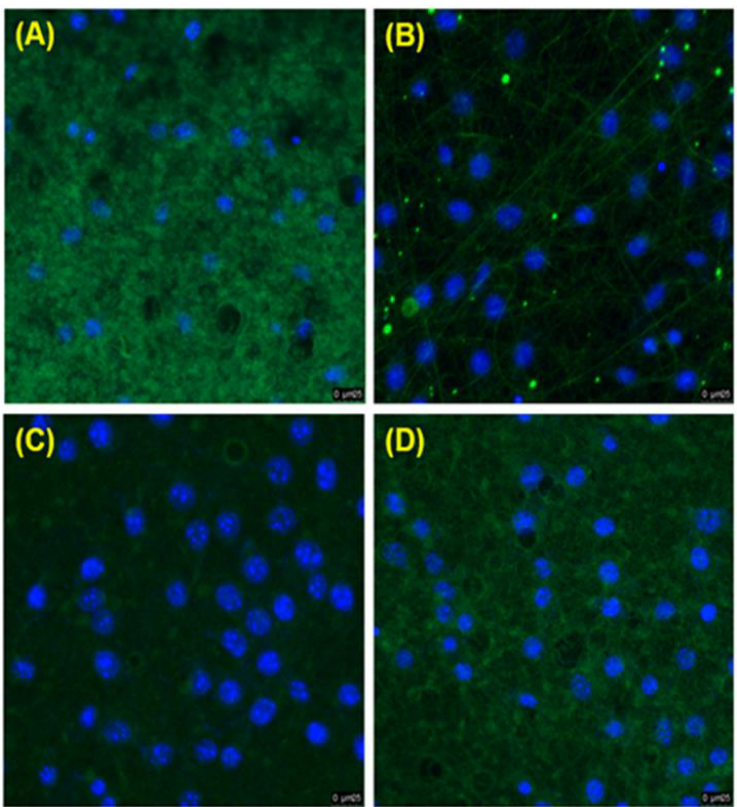
Figure 6. Immunofluorescence staining of L929 cells seeded and grown on di ff erent GEL membranes 24 hr. (A)GEL (B) GEL/L (C) GEL/C (D) GEL/L/C.